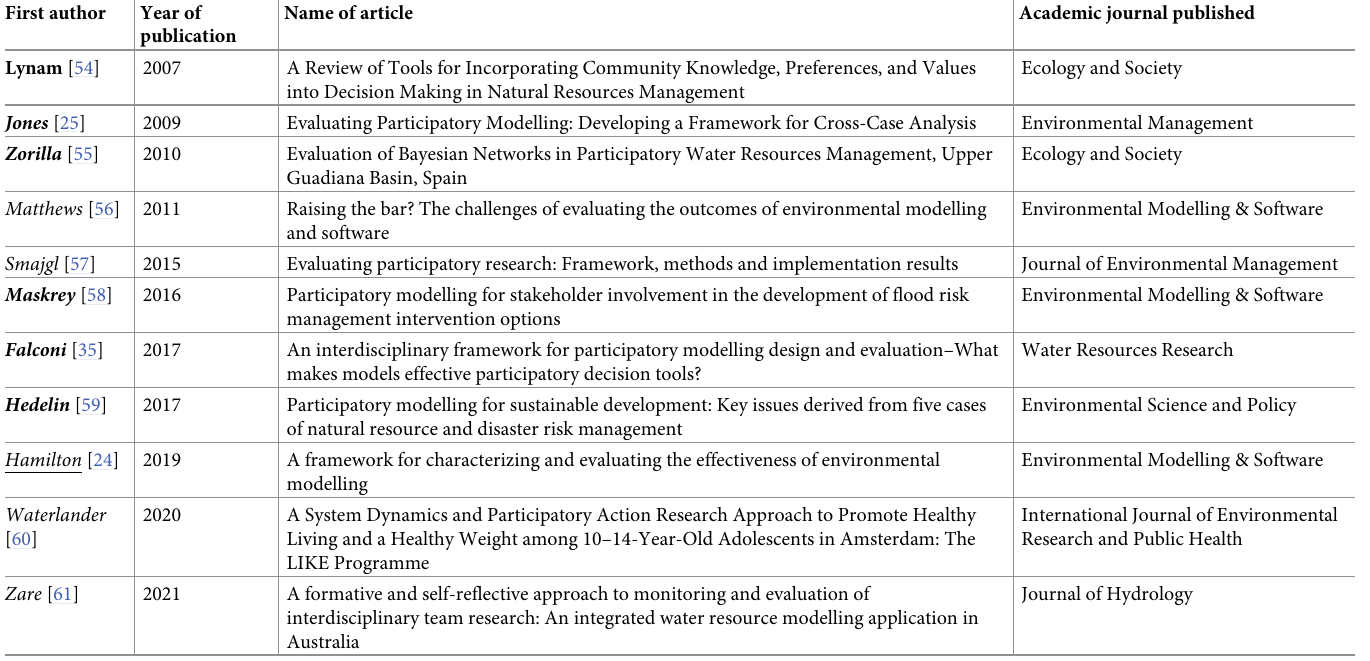
Table 4. Characteristics of included